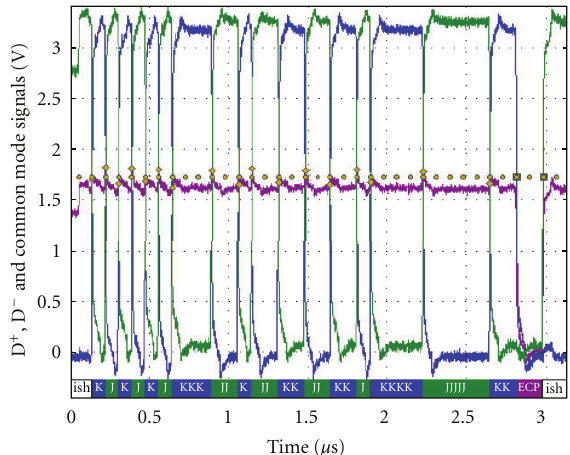
Figure 34: Measurement results from random data pattern of USB 2.0 specifications.